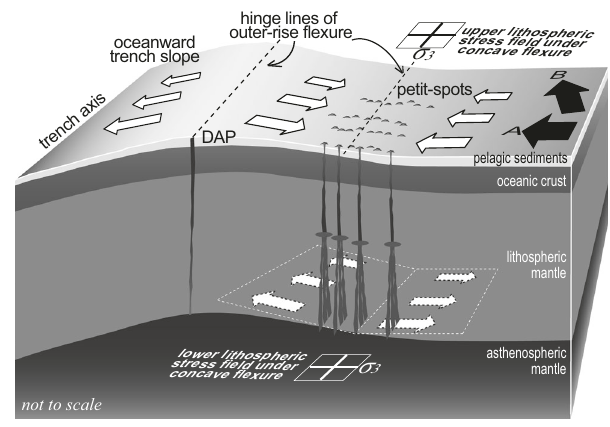
Fig. 2 Tectonic model of magma ascent through the concavely fl exed lithosphere. White arrows indicate the stress fi elds at the base and surface of the lithosphere. Magmas ascend from a tensional stress fi eld at the base of the lithosphere to a compressional stress fi eld in the upper lithosphere; the least compressive principle stress ( σ 3 ) rotates by 90° at middle lithospheric depths. The two black arrows indicate plate motions in the cases of the Japan and Sunda Trenches (A) and the northern Mariana Trench (B) (modi fi ed after ref. 2